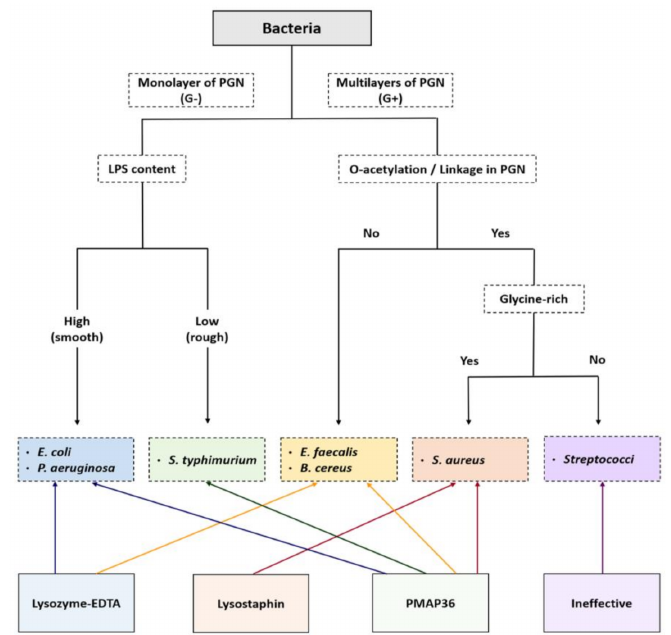
Figure 2. Diagram showing the relationship between the characteristics of bacterial cell walls and susceptibility to membranolytic proteins. Lytic proteins applicable to different bacterial species are shown at the bottom. PGN, peptidoglycan; LPS, lipopolysaccharide; O-acetylation, the N- acetylmuramic acid (NAM) and N-acetyl-D-glucosamine (NAG) linkage by acetylated oxygen; Linkage in PGN, cross-linked wall teichoic acids (WTA); E. coli , Escherichia coli ; P. aeruginosa , Pseu- domonas aeruginosa ; S. typhimurium , Salmonella typhimurium ; E. faecalis , Enterococcus faecalis ; B. cereus , Bacillus cereus ; S. aureus , Staphylococcus aureus